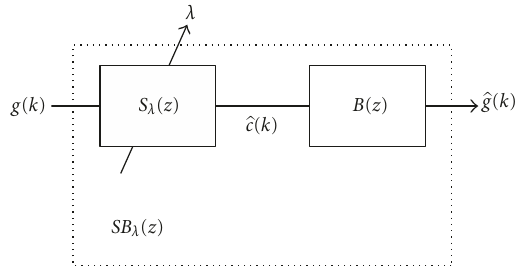
Figure 4: Block diagram of the smoothing B-spline filter SB λ . g ( k ) are the curve points. S λ ( z ) is a filter that computes the smoothing B-spline coe ffi cients (cid:9) c ( k ). B ( z ) is a filter that computes the B-spline curve points from a set of coe ffi cients. (cid:9) g ( k ) are the approximating points of g ( k ).